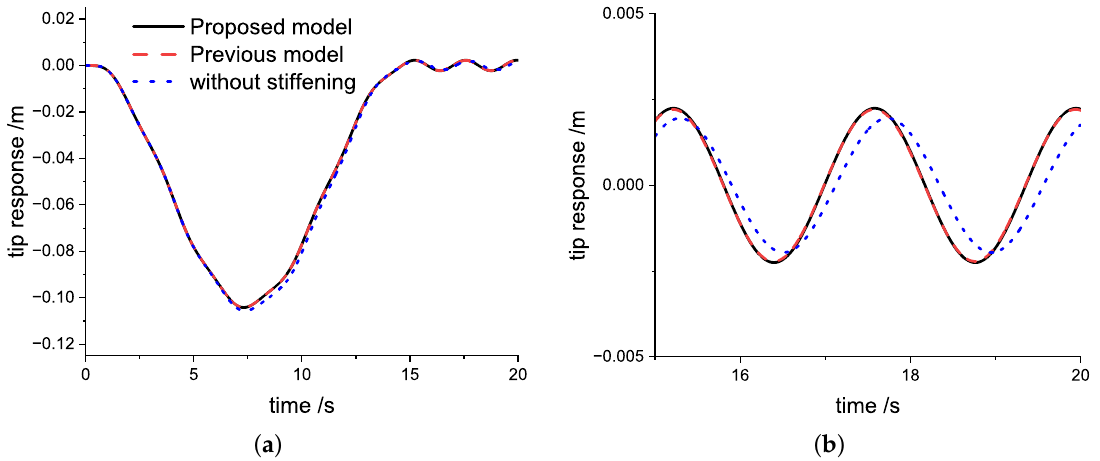
Figure 2. The response of the beam’s free end when Ω 0 = 0.6 rad/s: ( a ) Full time period; ( b ) Magnification of the uniform rotating stage.